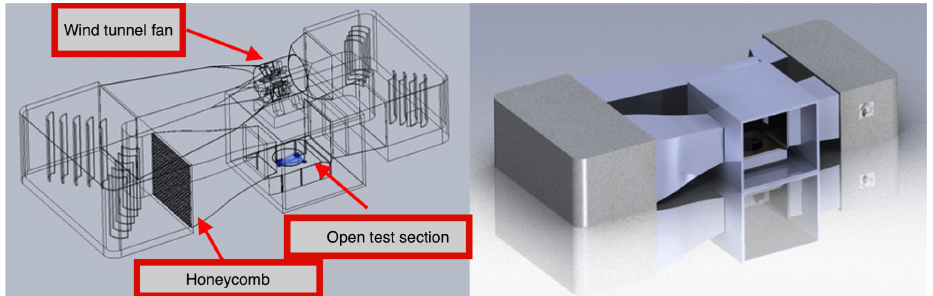
Figure 1. Layout of the “R.Balli” wind tunnel laboratory.